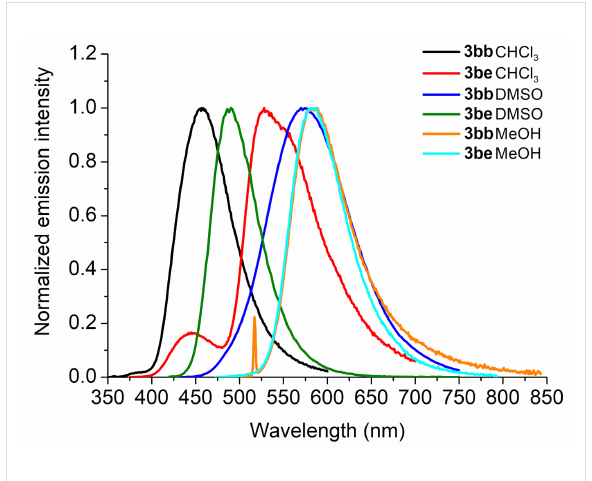
Figure 5: Comparative normalized steady-state fluorescence emis- sion spectra of compounds 3bb and 3be in the three studied solvents ([ ] = 1.50 × 10 − 5